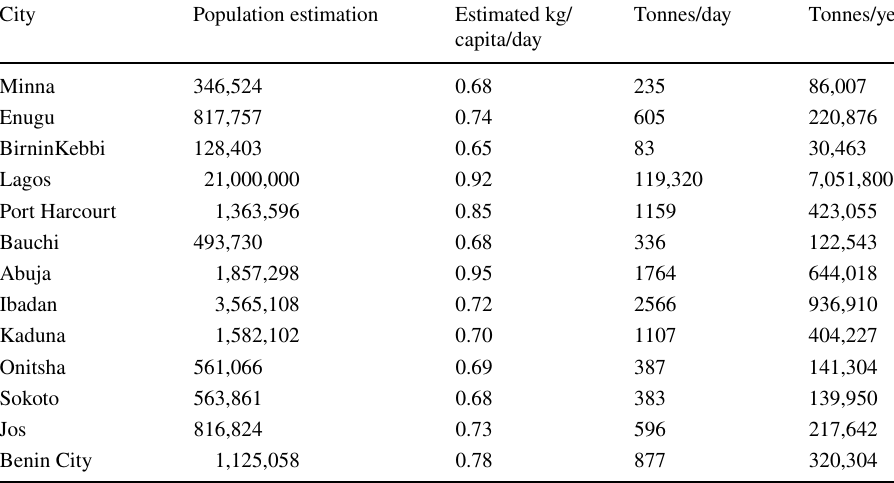
Table 1 Quantity of solid waste generated in some Nigerian cities. Source: *Population estimation (NPC 2006)